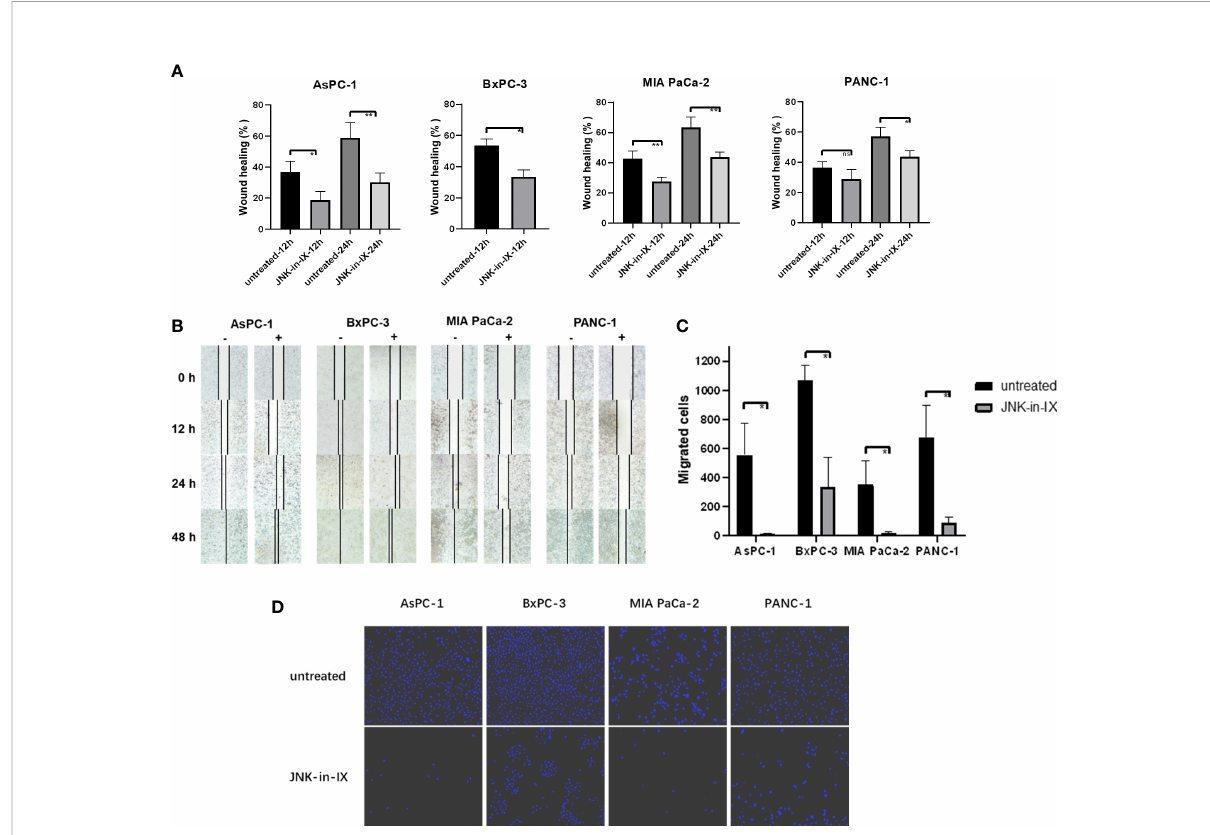
FIGURE 3 Effect of JNK-in-IX on pancreatic cancer cell mobility and migration. (A) Cell movement in the wound healing assay. Results are shown as wound healing distance (in % of 0 h) after 12 h and 24 h and are means of 5 separate experiments. The wound healing rate of BxPC-3 at 24 h is not shown as the wound margins were highly irregular. (B) Representative areas of wound gaps at 0 h, 12 h, 24 h and 48 h at 2.5× magni fi cation. (C, D) Modi fi ed Boyden chamber assay. Results are shown as number of the migrated cells within 24 h and are means of 5 separate experiments (C) with representative areas of migrated cells at 10× magni fi cation (D) . ns p>0.05, * p< 0.05, **